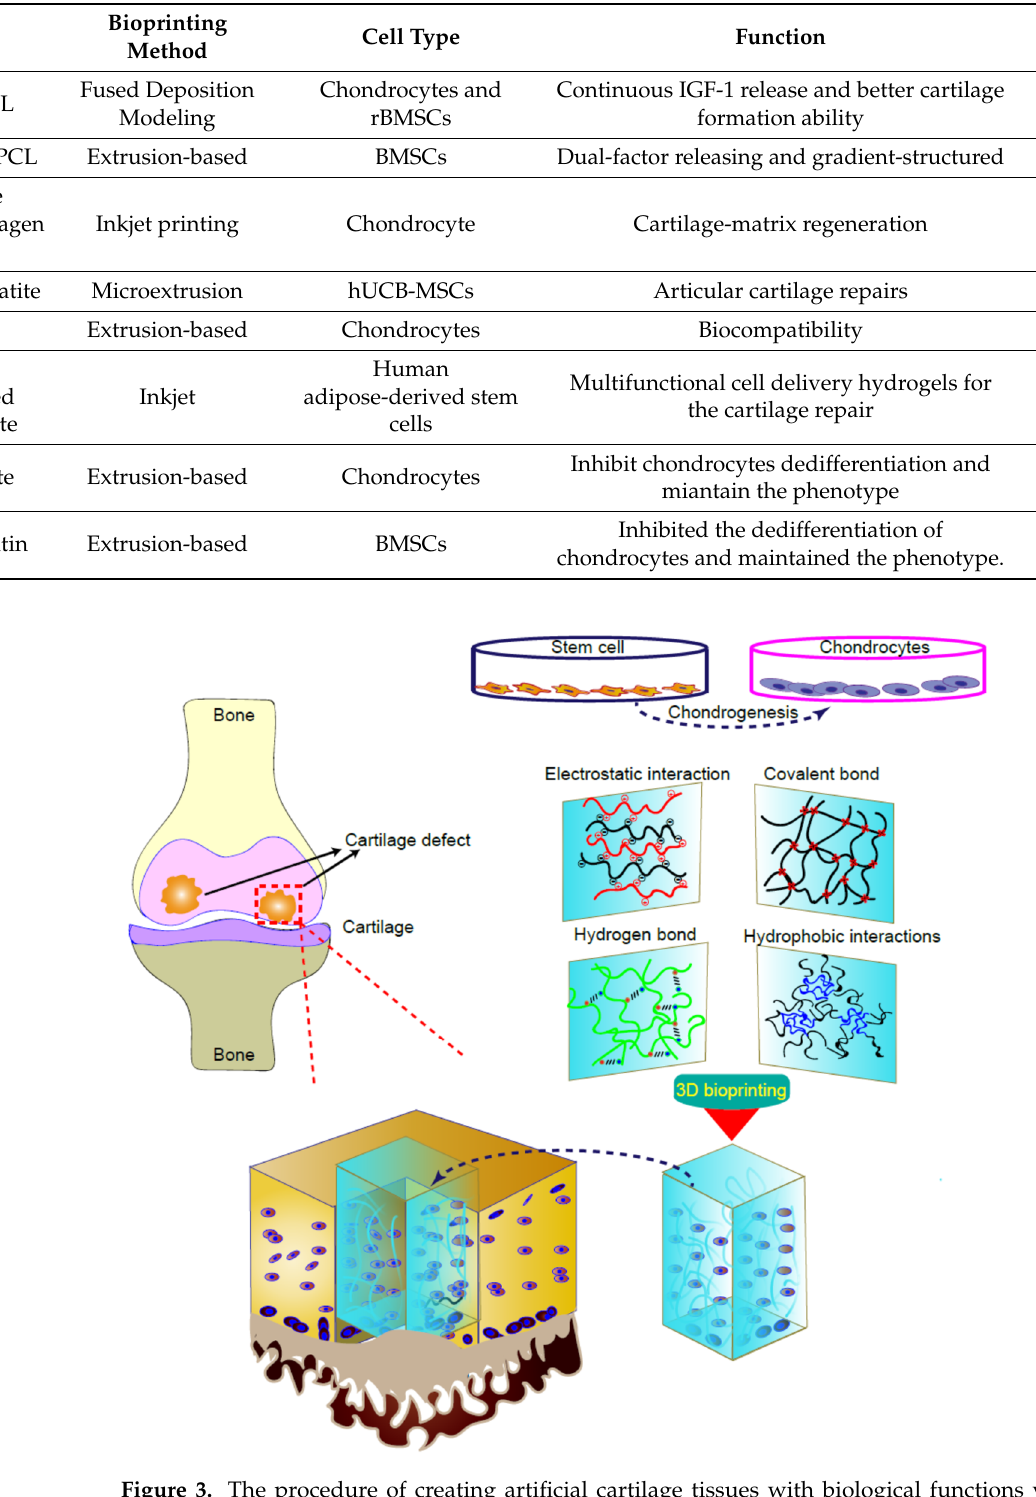
Figure 3. The procedure of creating artificial cartilage tissues with biological functions via 3D bioprinting. The regional characteristics of natural cartilage and the current 3D printing methods used for cartilage defect repair. With the 3D printing technology, the structure is captured from different areas of the cartilage, and the seed collagen fibers are formed into a layered scaffold; they are distributed in ribbons to simulate the structure of natural cartilage.